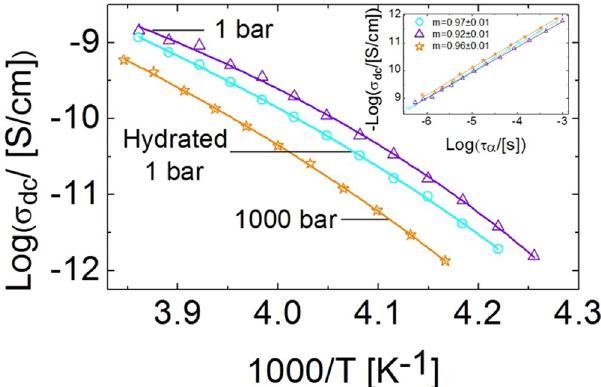
Figure 3. Ionic dc conduction in pure and hydrated prilocaine. Arrhenius plots of the dc conductivity σ dc for pure prilocaine at 1 and 1000 bars, together with that of hydrated prilocaine at 1 bar. Inset: logarithmic Walden plot ( σ dc vs τ ) for the same three samples.